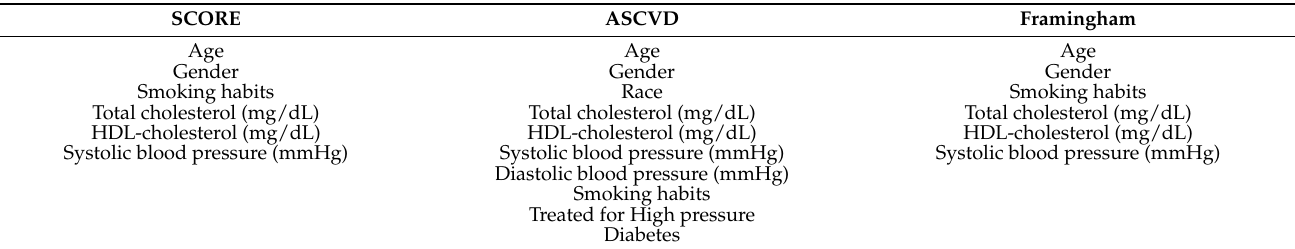
Table A2. Variables used by